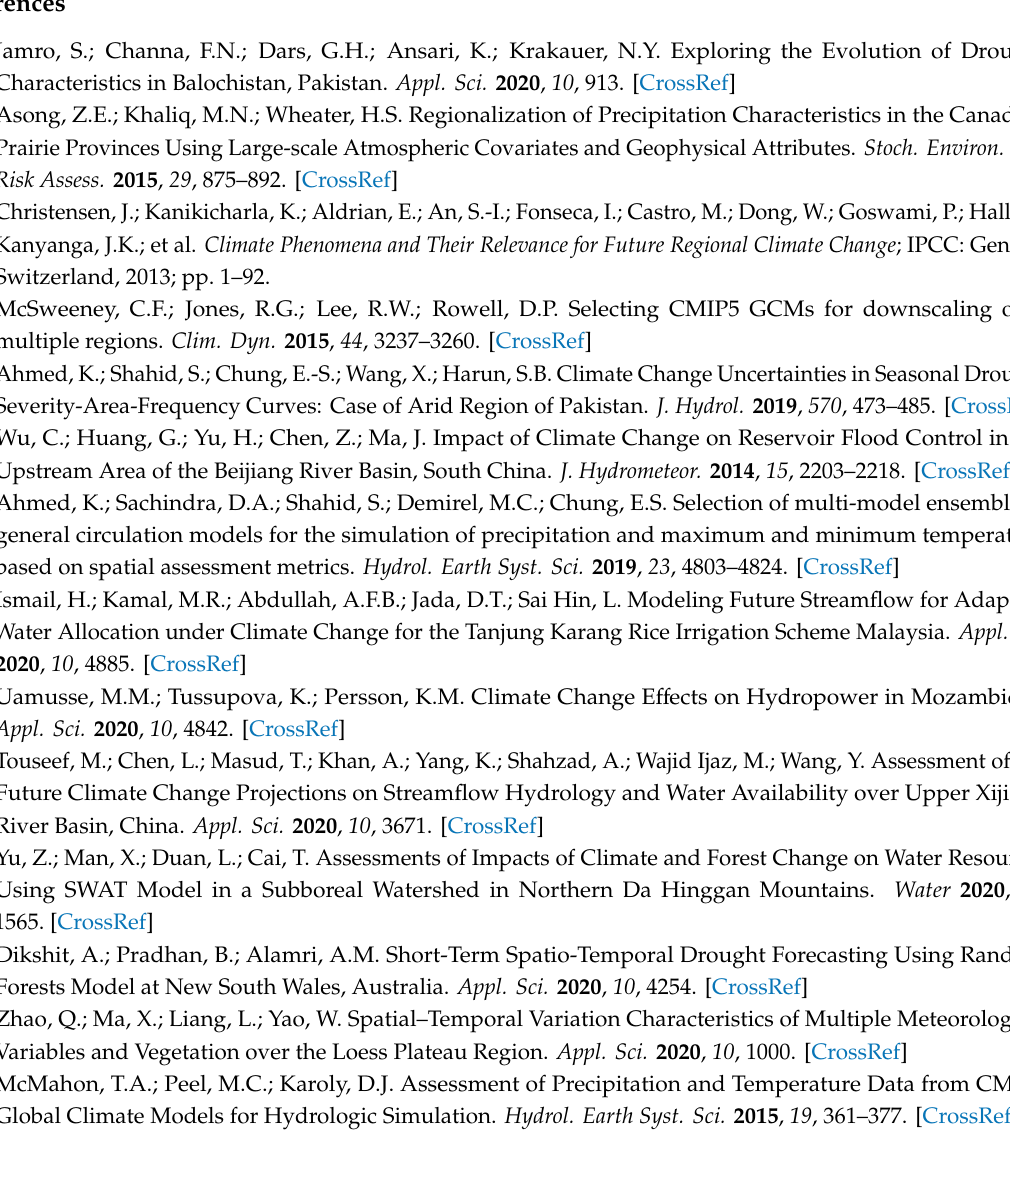
Table S1: Descriptions of the GCMs used in the study